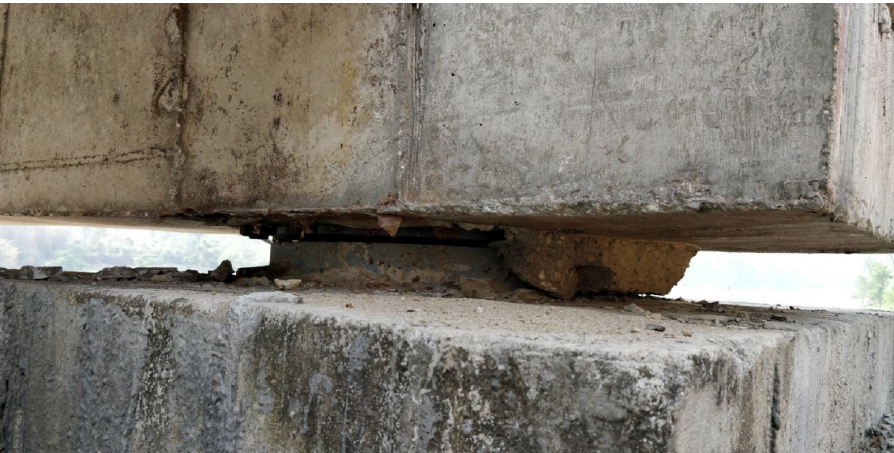
Figure 13. Pot bearing system above Abutment-2 (Undamaged).